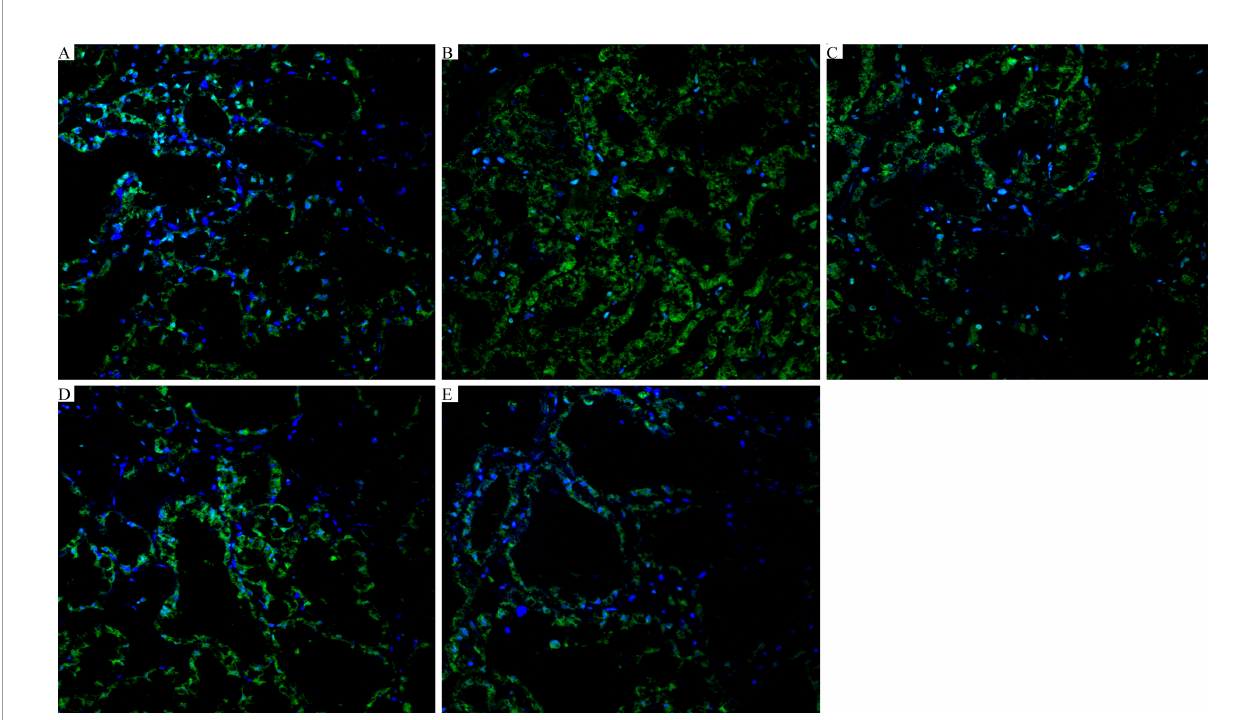
FIGURE 6 | FOR suppresses the LPS-induced blood-milk barrier disruption (magni fi cation 400×). (A) Control group: normal mammary gland tissue structure. (B) LPS group: severe FITC-albumin in fi ltration and exfoliation of epithelial cells. (C – E) LPS + FOR (10, 20, 30 mg/kg) groups: gradually intact blood-milk barrier after administration of FOR. Blue spots represented the nuclei; green spots were